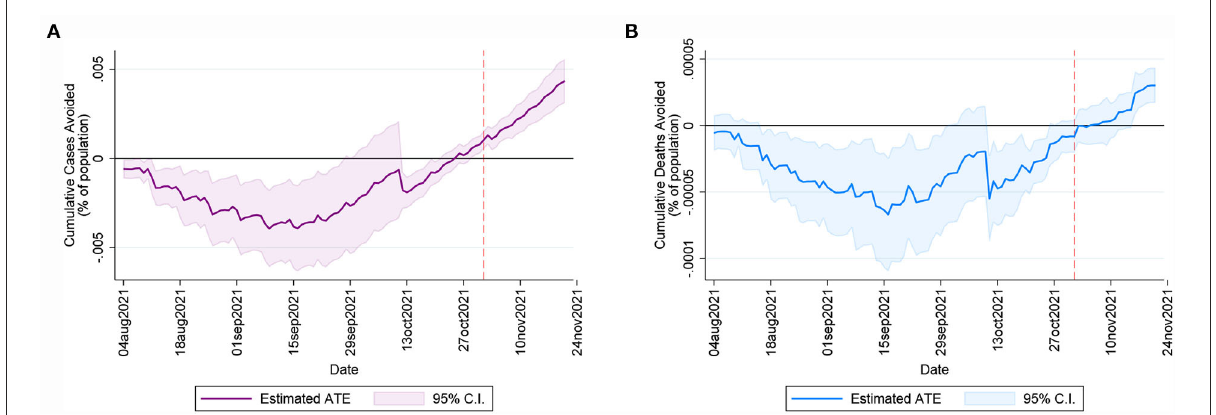
FIGURE3 Impacts on Tyson Food’s employee mandate on county-level COVID-19 incidence. Figure summarizes the impacts of Tyson’s employee vaccine mandate on county-level COVID-19 incidence from August 4, 2021 through November 21, 2021. (A) shows the impacts on COVID-19 case rates over time, and (B) shows the impacts on COVID-19 death